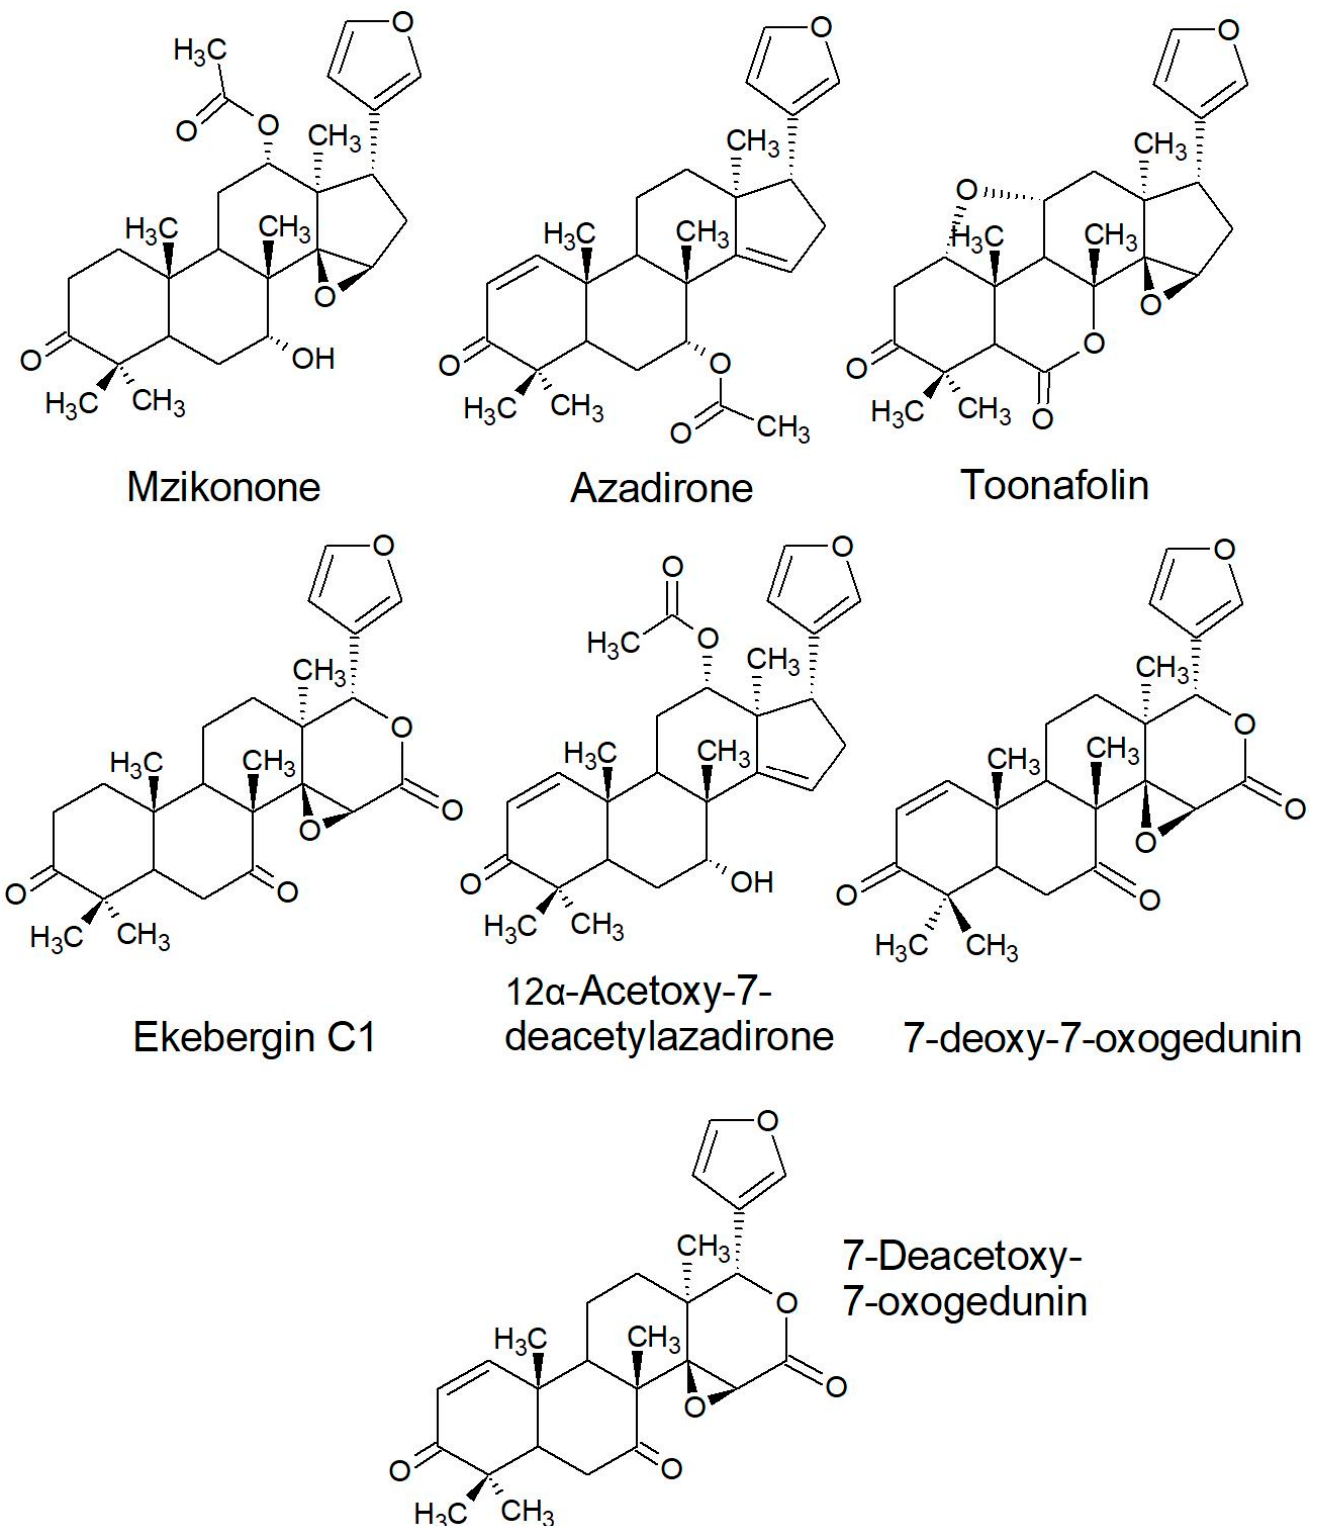
Figure 6. Ketone series of limonoids reported from South African Meliaceae [33,146,147].